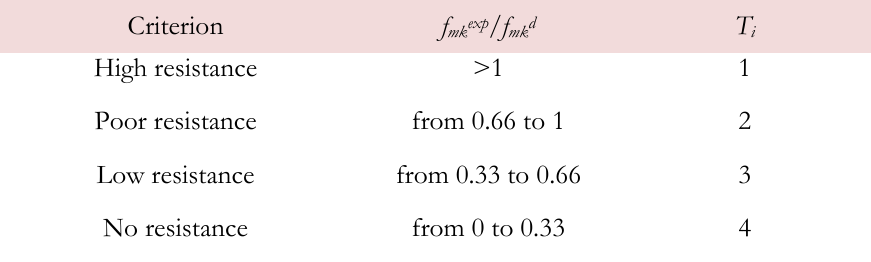
Table 2: Material characteristics degradation: T i values.